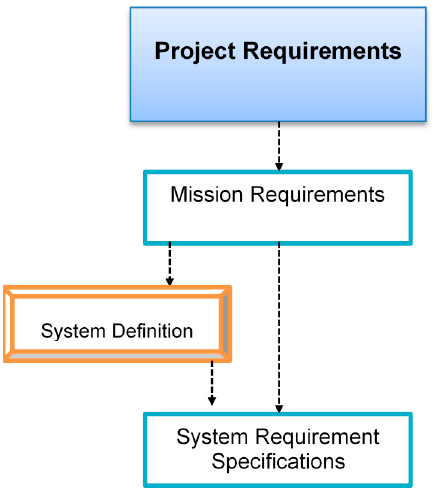
Figure 4. Requirement tree.